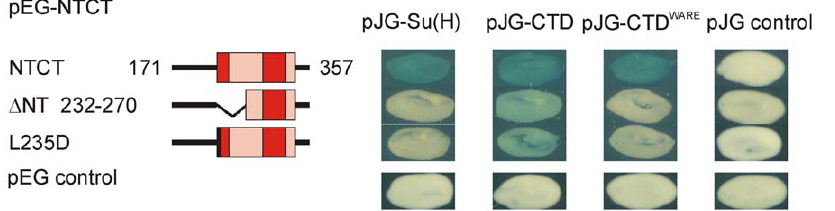
Figure 3. Su(H) WARE binding capacity to Hairless mutants. Yeast two-hybrid assay to test for binding activity of wild type Su(H), CTD and mutant CTD WARE constructs with Hairless NTCT, NTCT D NT Dand NTCT LD ; empty vector served as a negative control. Note the lack of binding of CTD WARE with the D NT deletion or the NTCT LD mutation.